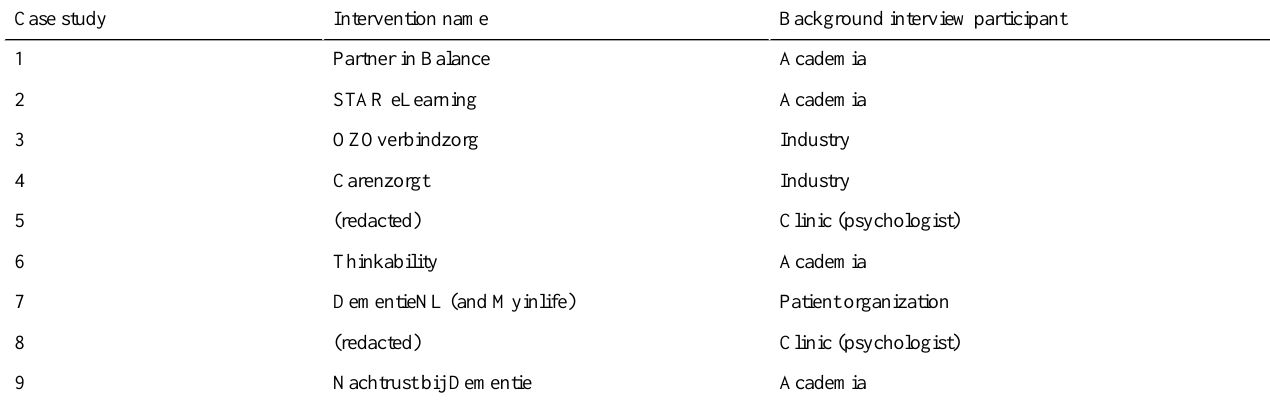
Table 1. Interview